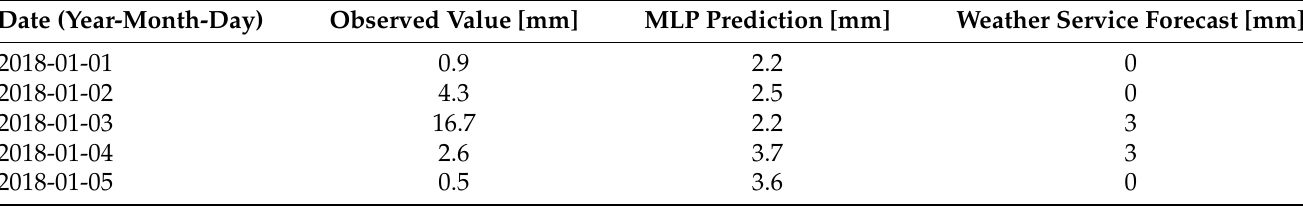
Table A21. Comparison of the MLP and weather service forecast for the daily precipitation